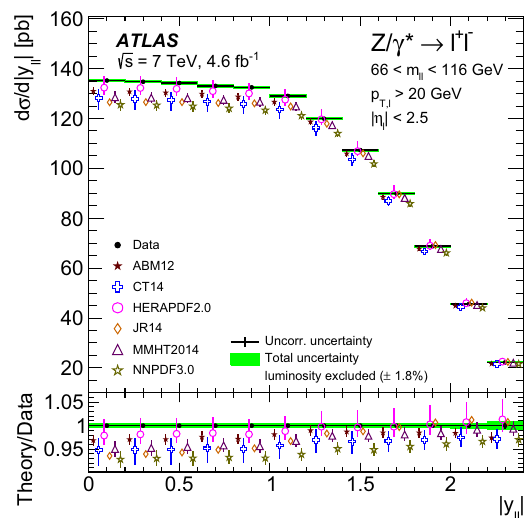
theoretical predictions to the data is also shown. The predictions are displaced within each bin for better visibility. The theory uncertainty corresponds to the quadratic sum of the PDF uncertainty and the statistical uncertainty of the calculation